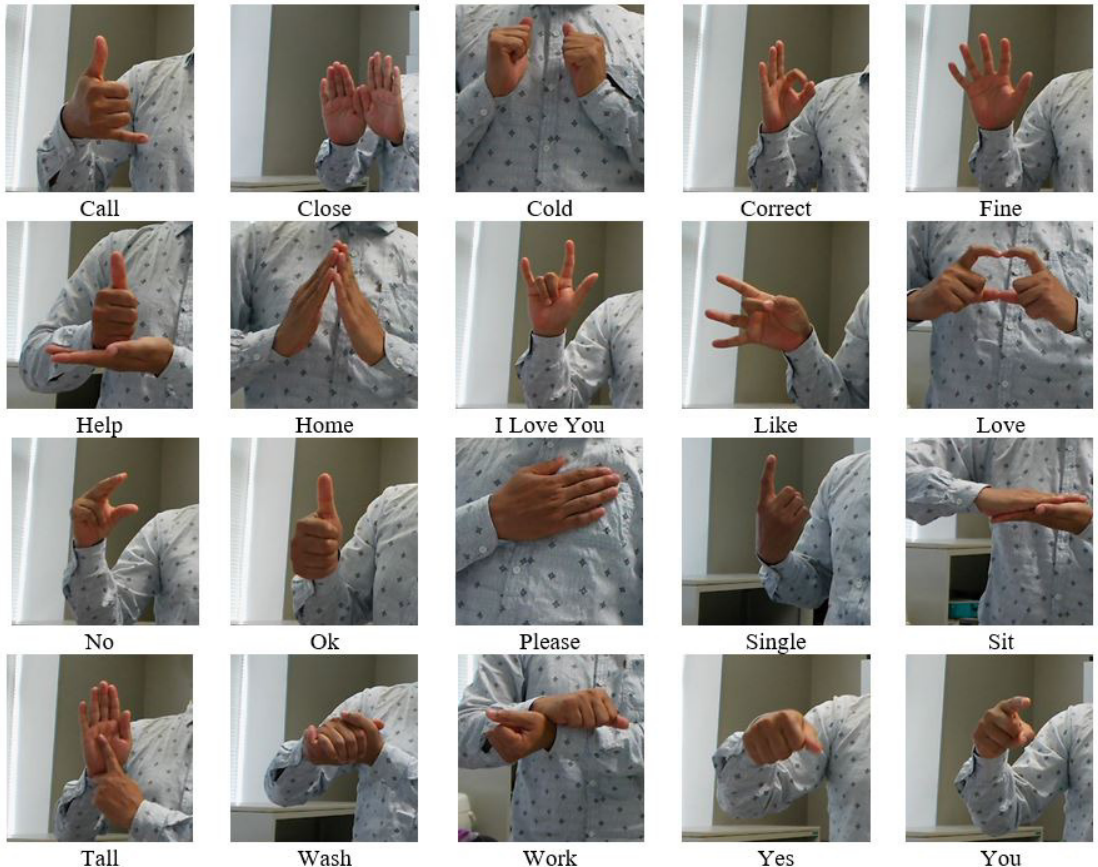
Figure 8. Example of the dataset images.